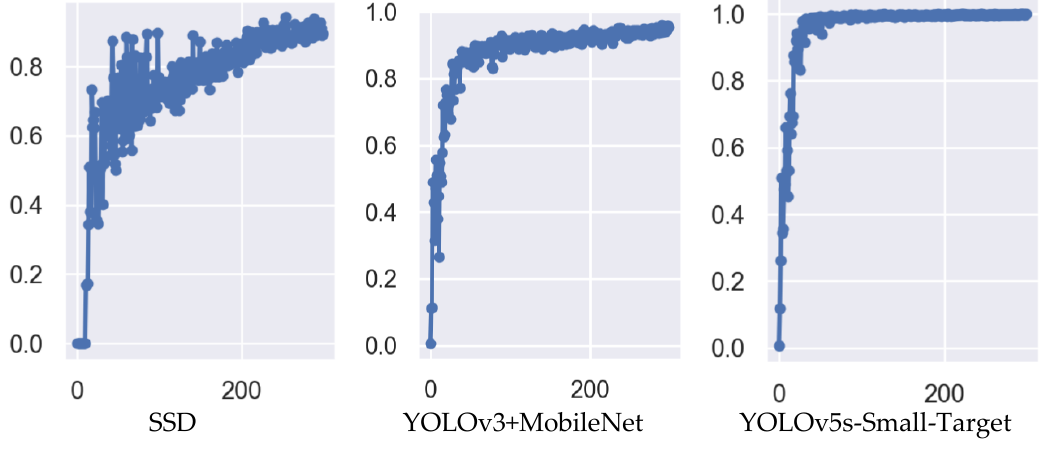
Figure 19. Comparison of defect detection precision of different detection algorithms.